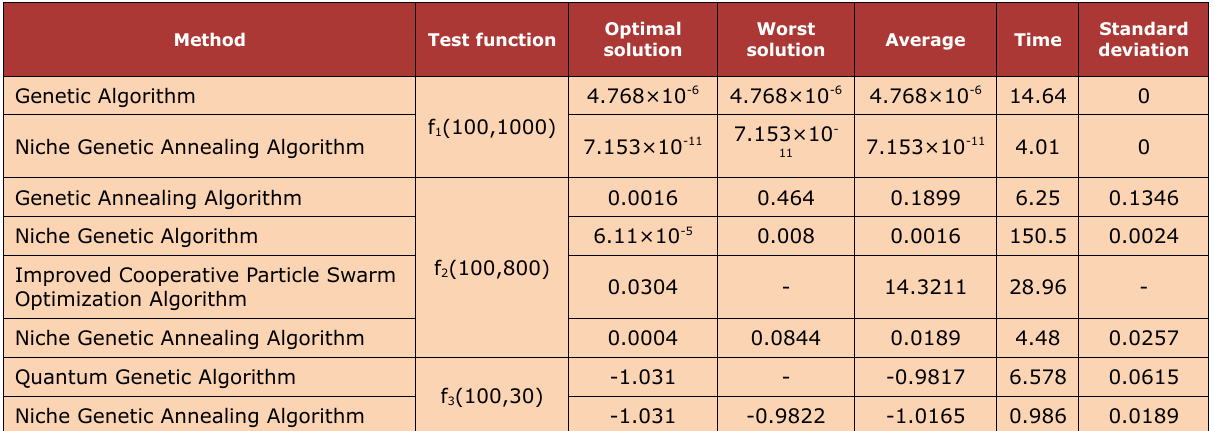
Table 4. Performance comparison of each method